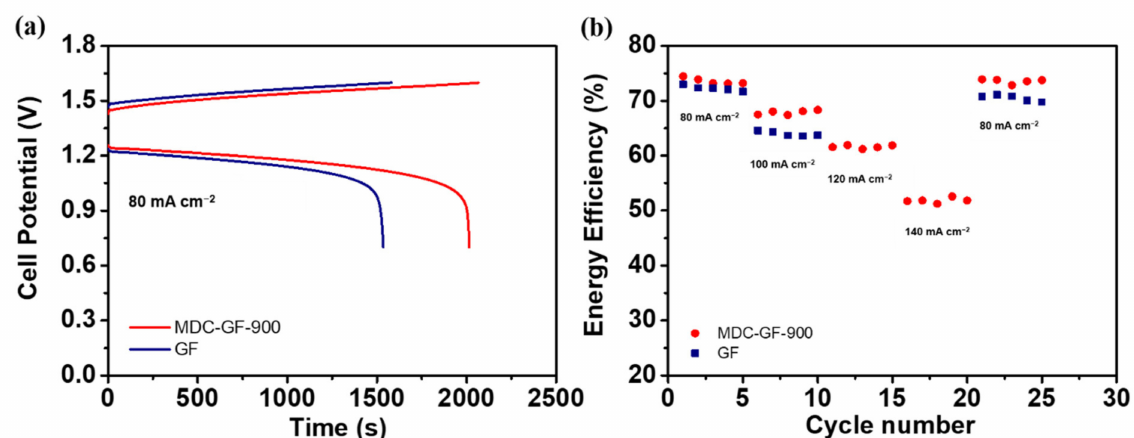
Figure 8. The performance for charge-discharge tests of single cells using ( a ) MDC-GF-900 and GF electrodes at 80 mA cm − 2 ; ( b ) The energy efficiency (EE) of single cells with different electrodes at 80, 100, 120, and 140 mA cm − 2